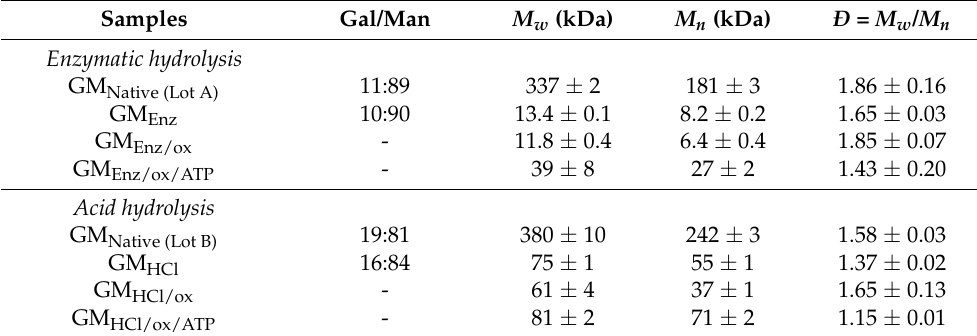
Table 1. Gal/Man monosaccharide ratio of native and hydrolyzed GM. M w , M n , and Ð analysis of GM. Samples were analyzed in the native form, after enzymatic hydrolysis (Lot A) and acid hydrolysis (Lot B), after oxidation with sodium periodate, and after reductive amination.